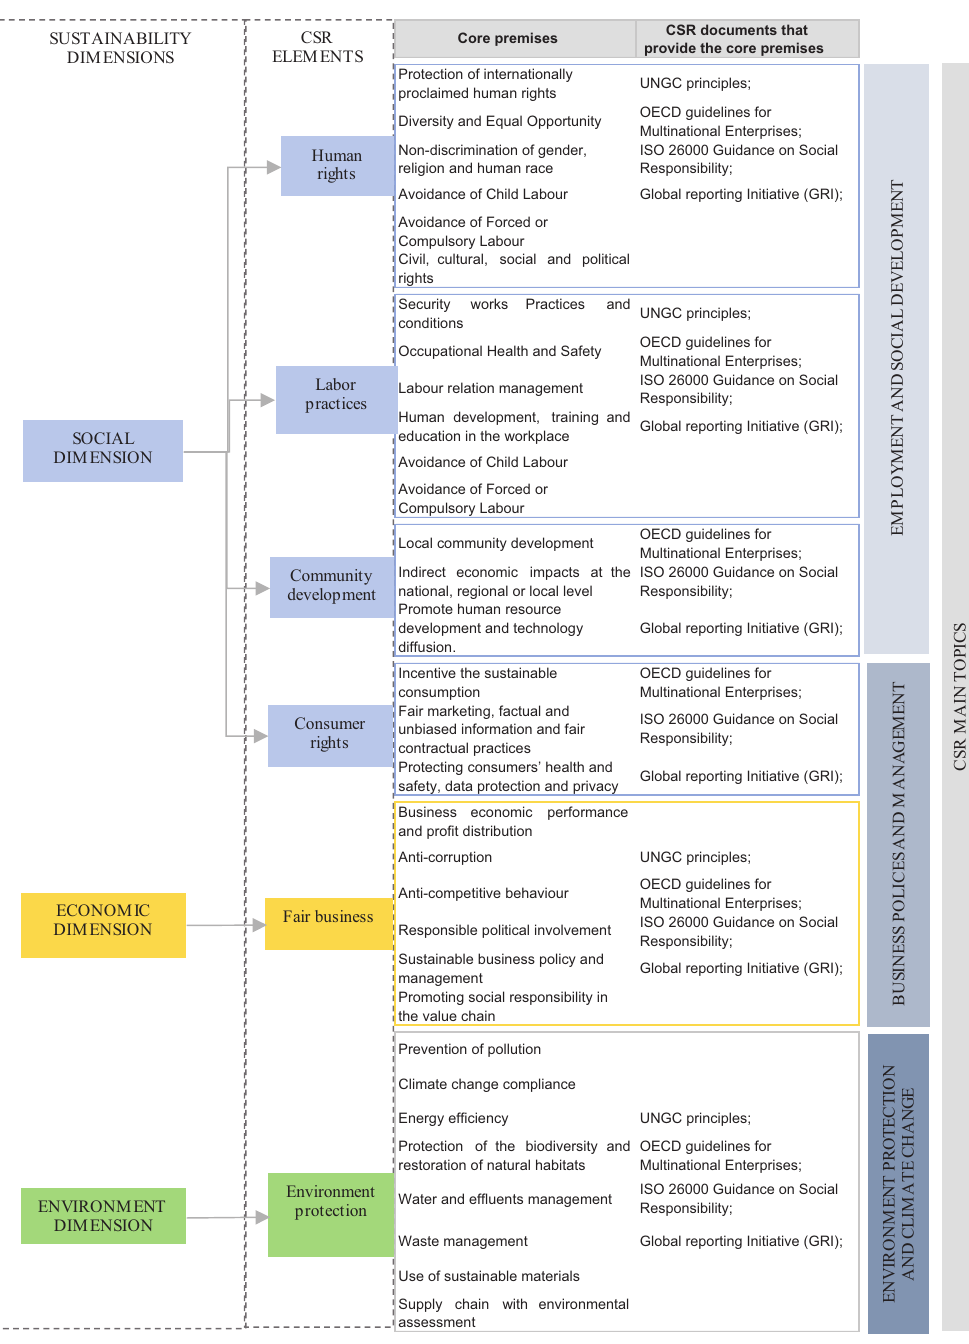
Figure 5. The CSR core premises used for commercial property corporate governance to create the company’s values, actions and strategies (source: elaborated by the